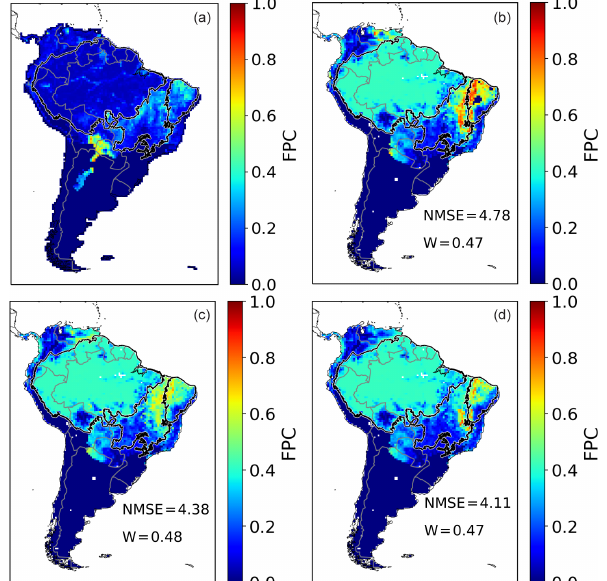
Figure A1. Annual FPC cover by tropical broadleaved raingreen PFT over a mean from 2005 to 2015 as fraction per cell. (a) ESA CCI evaluation data. (b) Simulated FPC by LPJmL4-SPITFIRE us- ing the NI orig version. (c) Simulated FPC by LPJmL4-SPITFIRE using the VPD optim version. (d) Simulated FPC by LPJmL4- SPITFIRE using the NI optim version.